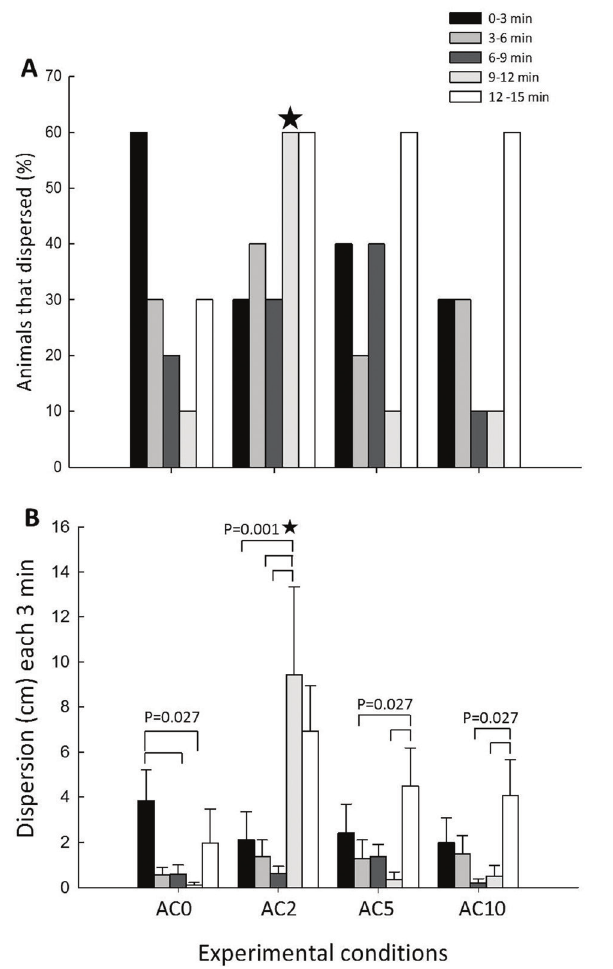
Fig. 4. (A) Percentage of fish that dispersed and (B) dispersion area along consecutive time windows of 3 min of recording. Lines correspond to differences along a time series for a same experimental condition. Stars indicate differences between the extract-exposed (AC2, AC5, AC10) and control groups (AC0).